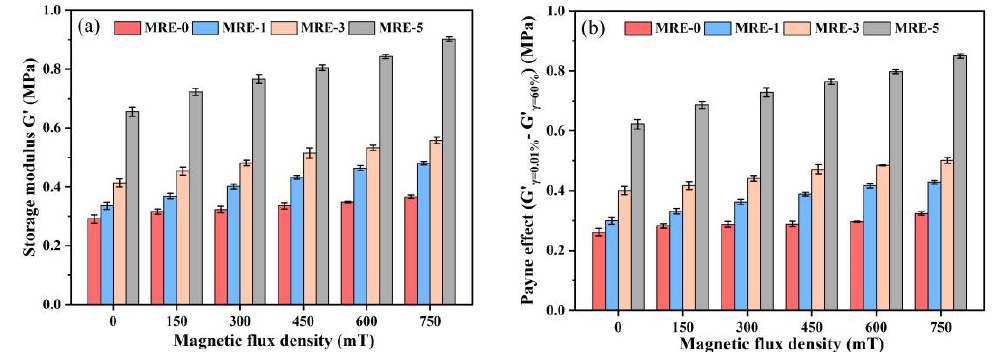
Figure 11. ( a ) Storage moduli at 0.01% strain amplitude; and ( b ) Payne effect (G’ γ=0 . 01% − G’ γ=60% ) of the MREs under various magnetic fields. of the MREs under various magnetic